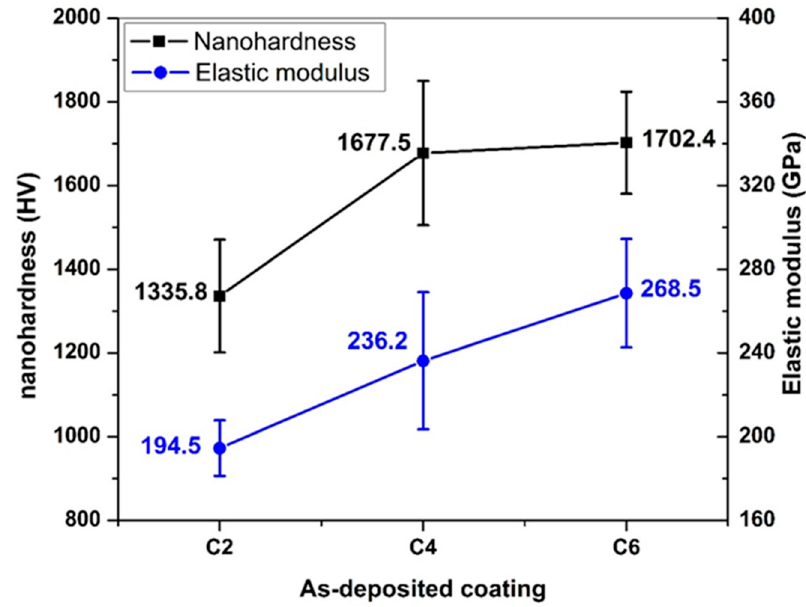
Figure 5 . Nano-hardness and elastic modulus of C2, C4 and C6 . Figure 5. Nano-hardness and elastic modulus of C2, C4 and